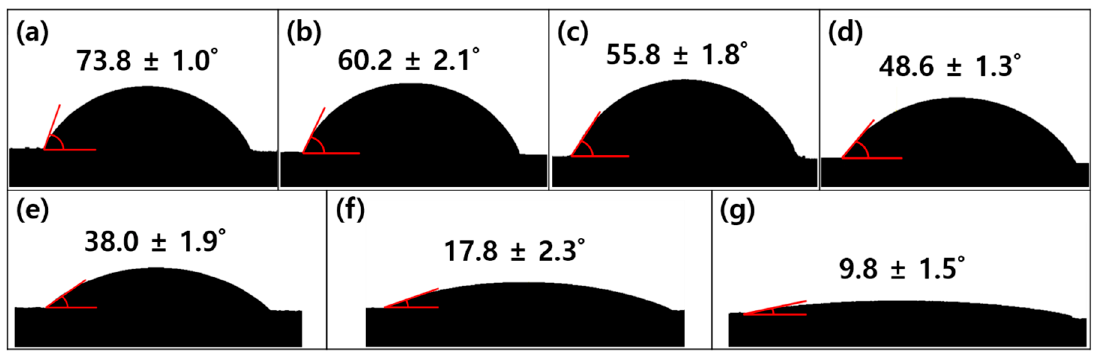
Figure 9. Water contact angles for: ( a ) PI, ( b ) PIL9:1, ( c ) PIL73, (d) PIL55, ( e ) PIL3:7, ( f ) PIL19, and ( g ) LPEGMASQ82 .